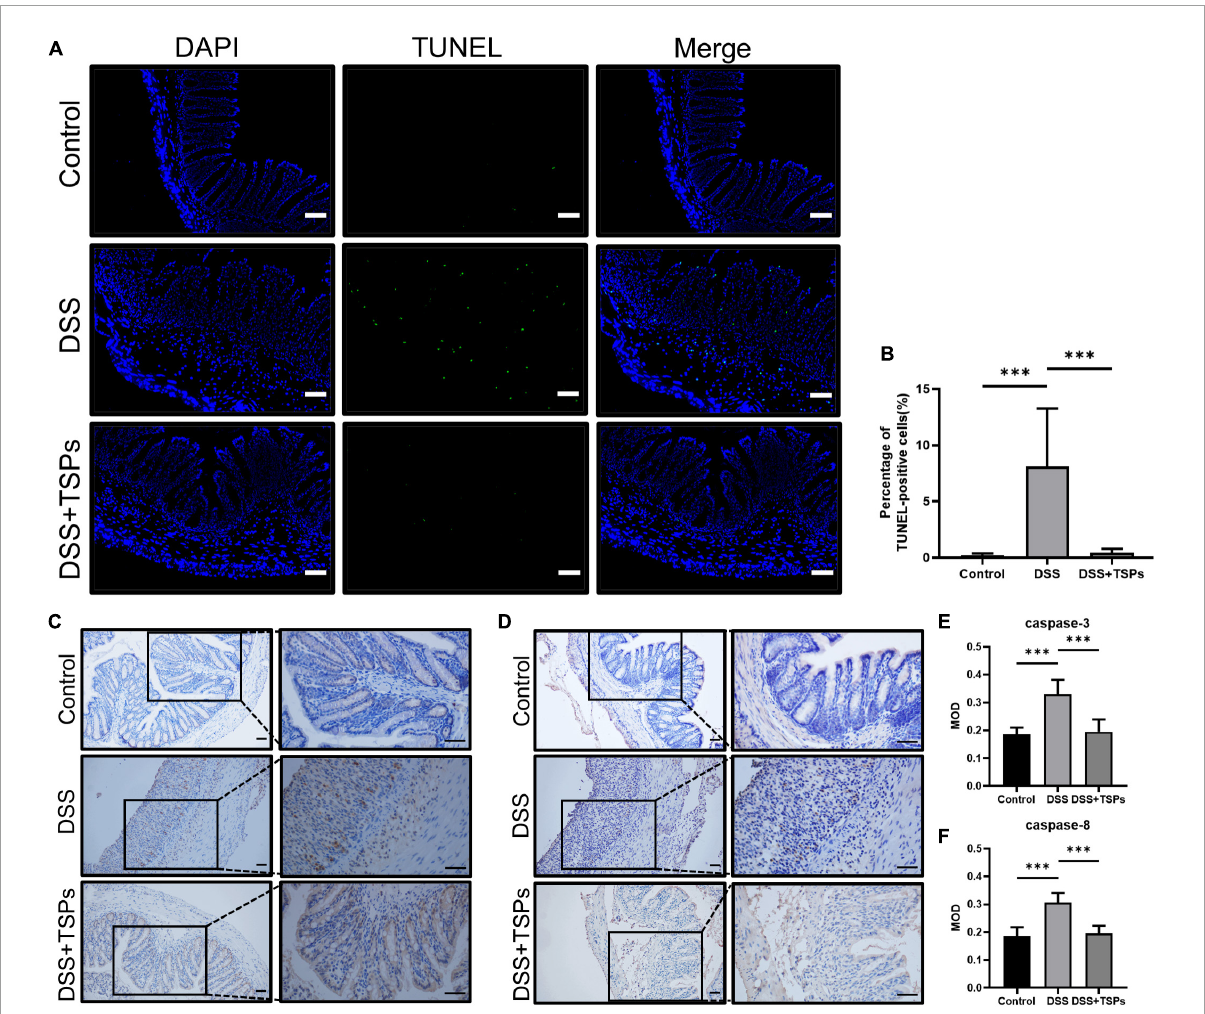
FIGURE7 Oral TSPs reduced DSS-induced apoptosis. (A) Immunofluorescence TUNEL staining of colonic sections. Scale bars = 50 µ m. (B) Apoptosis rate in colonic sections ( n = 8). (C) Representative images of immunohistochemistry staining for caspase-3 protein. Scale bar = 50 µ m. (D) Representative images of immunohistochemistry staining for caspase-8 protein. Scale bar = 50 µ m. (E,F) Immunohistochemical image gray-scale analysis of the caspase-3 and caspase-8 of the mean of density (MOD) ( n = 8). Data were presented as means ± SD. Statistical significance was determined using one-way ANOVA. ∗∗∗ P <